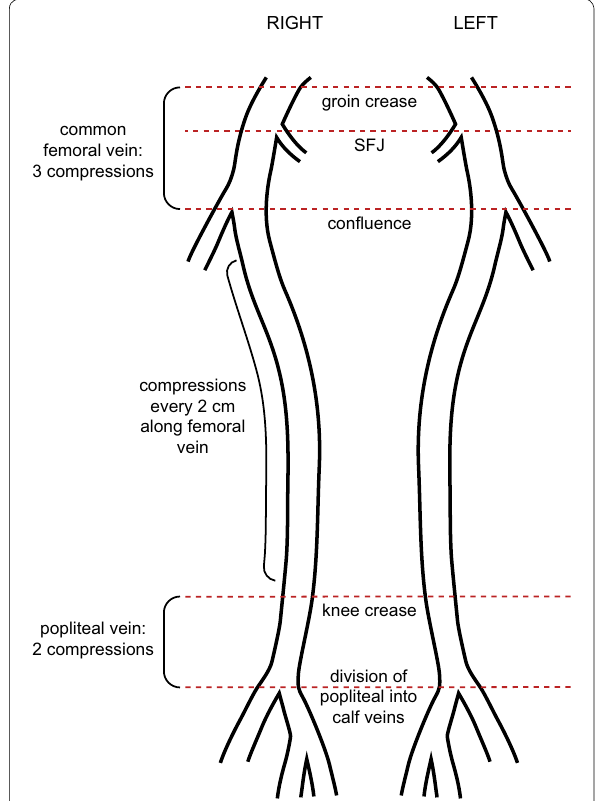
Fig. 1 Schematic diagram of deep veins in the lower limbs showing the compression points. The intensivist-performed compression ultrasound scan protocol consisted of compression of common femoral, femoral, and popliteal veins. Common femoral vein compression was performed at groin crease, saphenofemoral junction (SFJ) and confluence of femoral and deep femoral veins. Femoral vein compression was performed at 2 cm intervals along the vein below the confluence and popliteal vein compression was performed at the groin crease and the confluence of calf veins